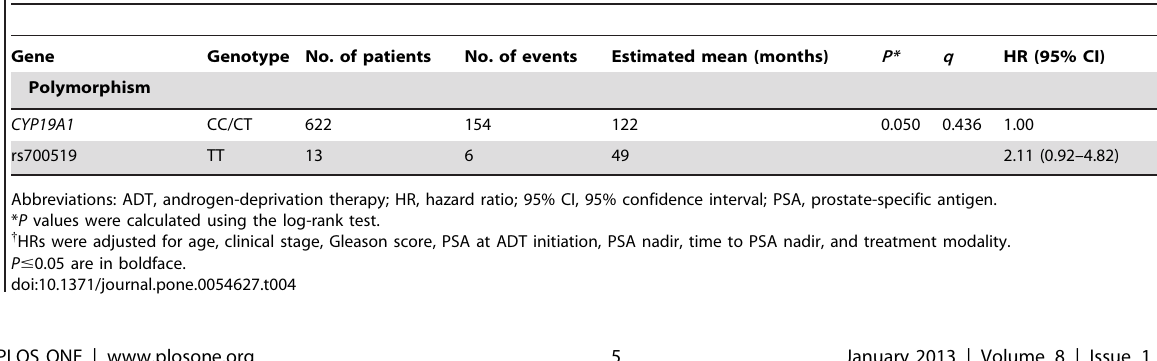
Table 4. Genotyping frequencies and the association of genotype with ACM during ADT.